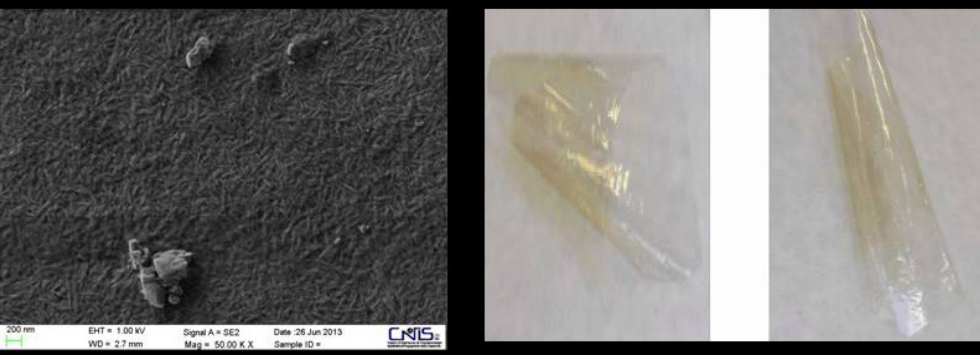
Figure 18. Film-tissue obtained by the casting method at SEM and as final product.